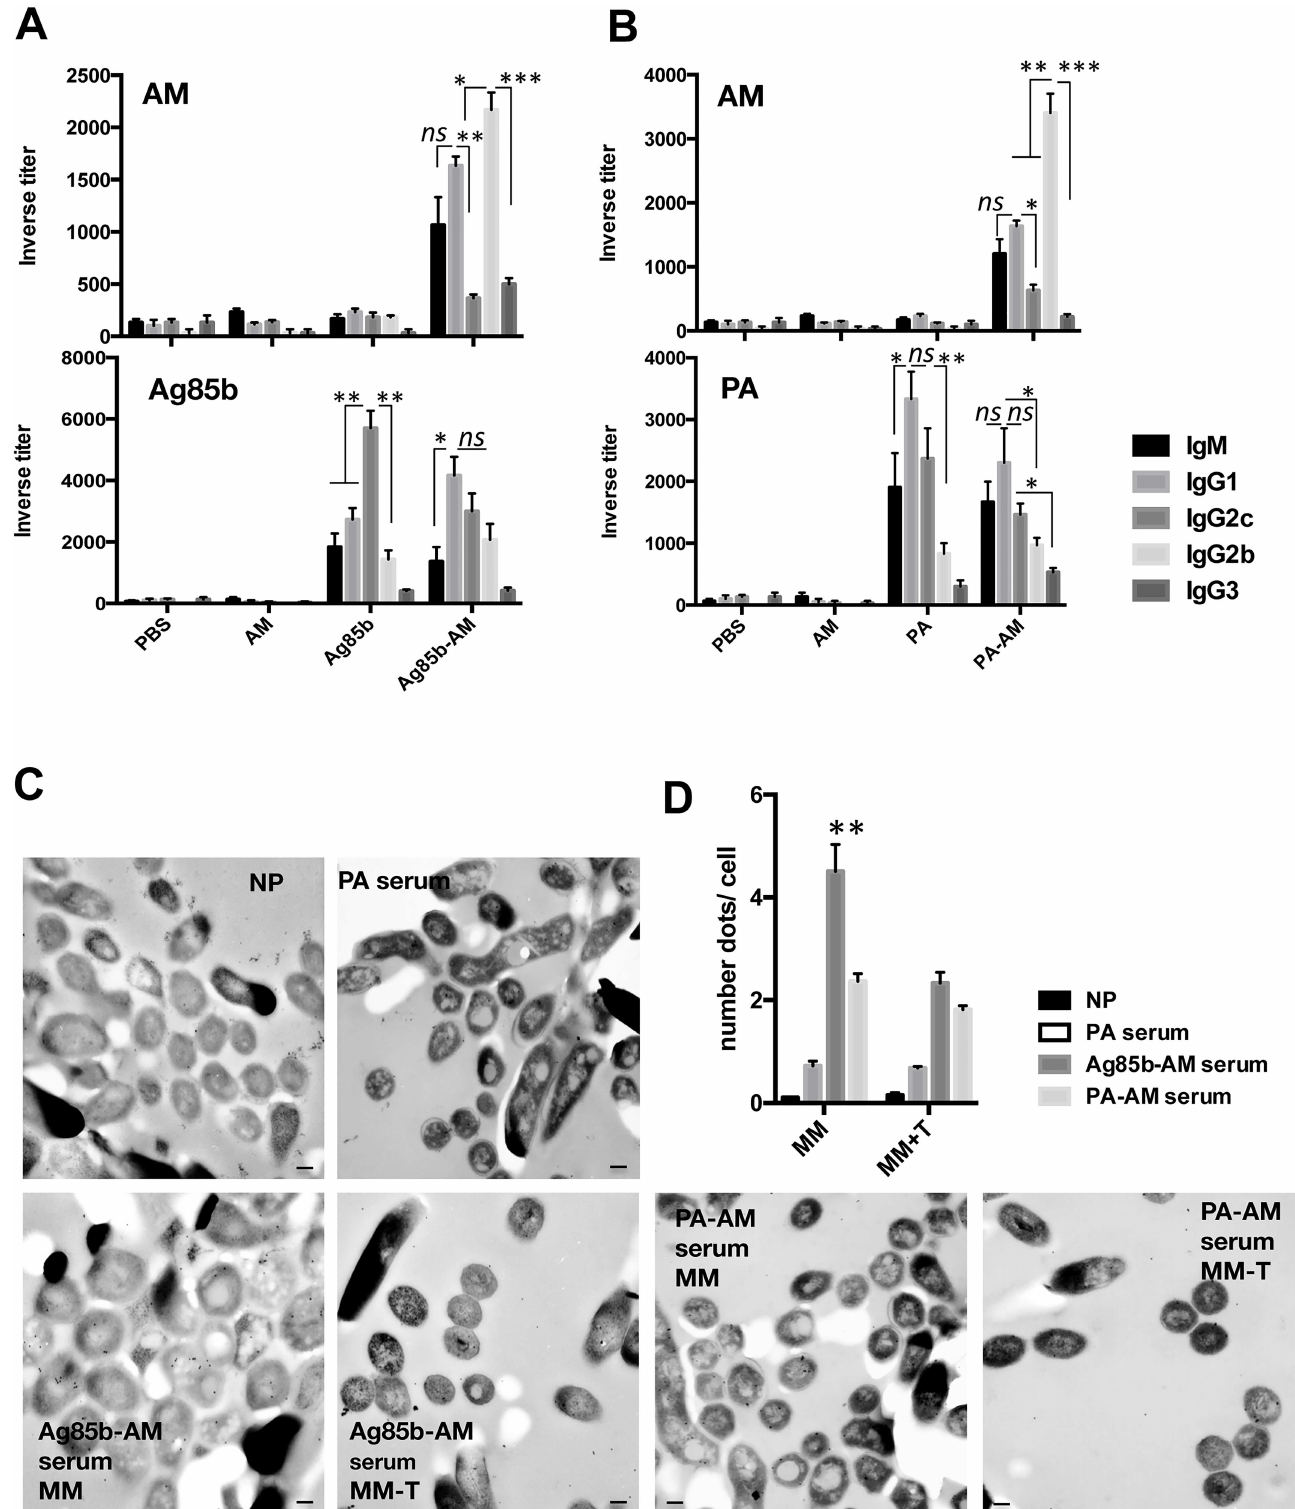
Fig 1. Antibody response to conjugate immunization in mice. (A) Titers of AM (Mtb) (top graph) or Ag85b (bottom graph)-specific antibodies measuredby ELISA in serum from C57BL/6mice ( n = 3 per group) immunizedwith 10 μ g of AM-Ag85b conjugate,1 μ g of Ag85b, 10 μ g of AM or PBS.